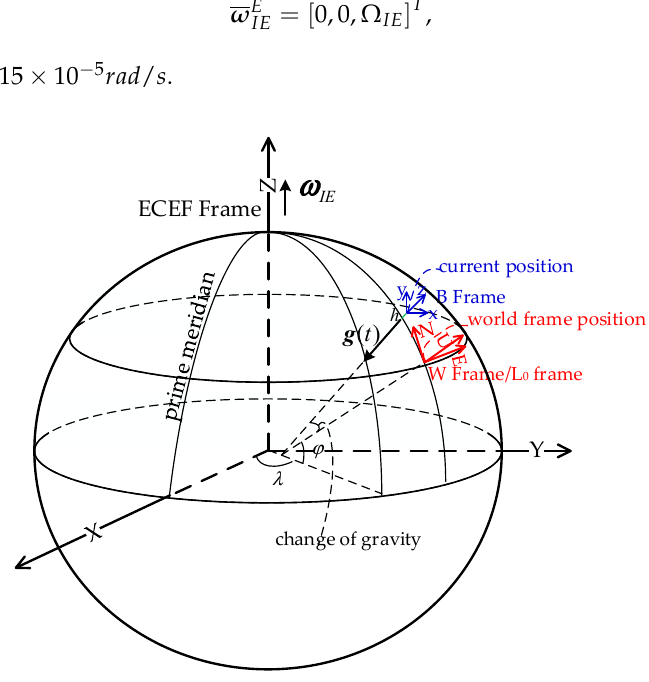
Figure 1. The earth model and related coordinate frames.